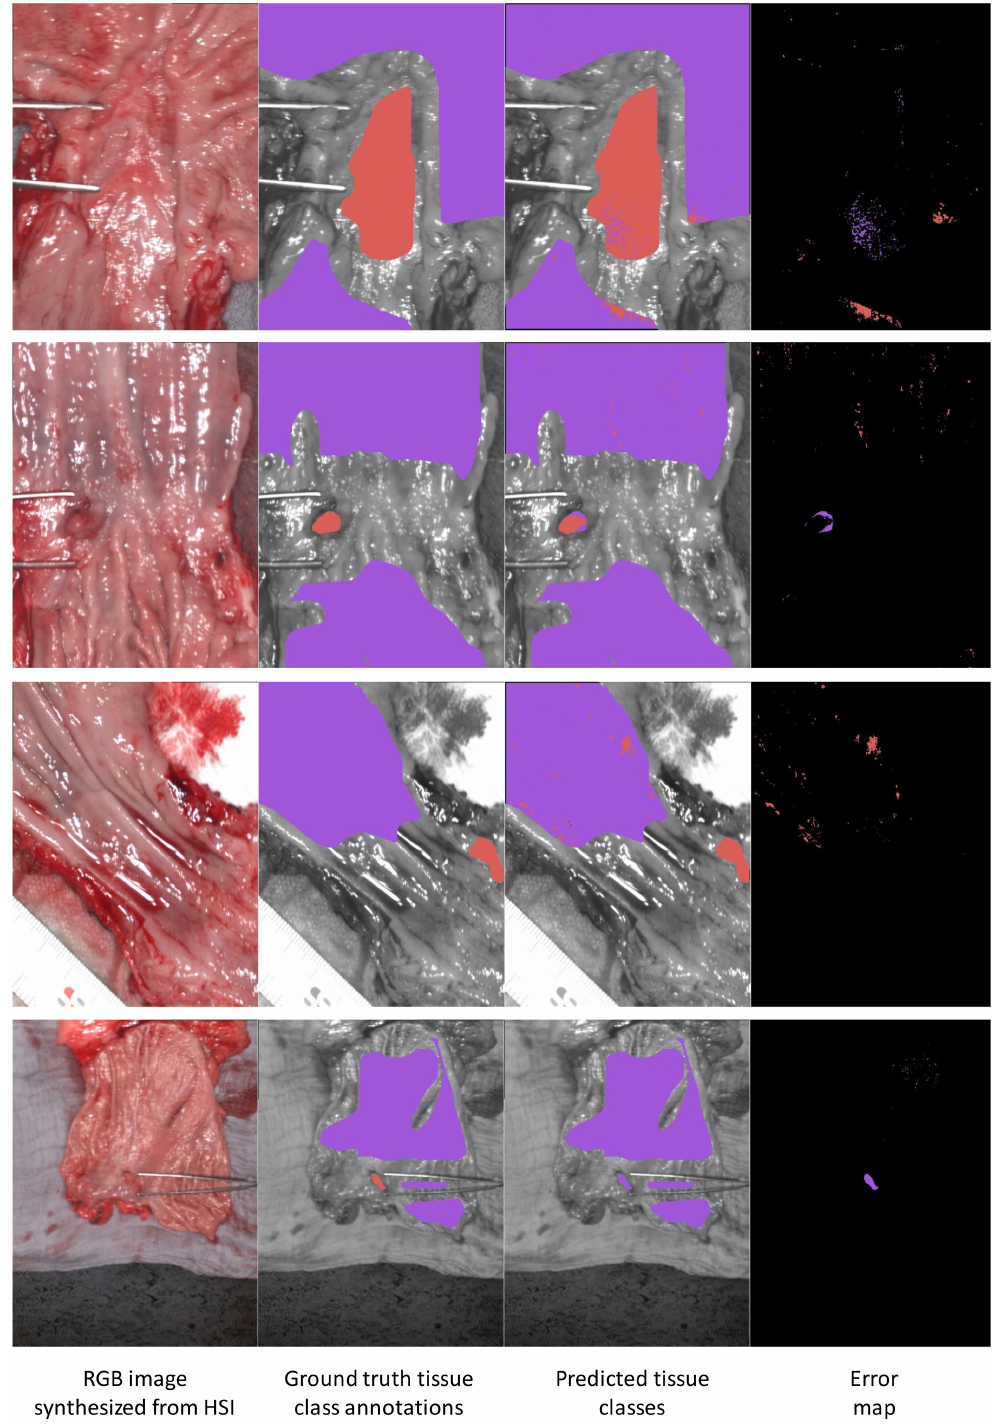
Figure 4. Visualization of results of the 3DCNN model on the esophagogastric dataset. Each row of images represents a patient (from top to bottom, patients 21, 19, 14 and 20). Each row of images shows four images. From the left, these are: (1) The RGB image synthesized from the hypercube. (2) The ground truth tissue class annotations provided by the surgeon. (3) The predicted tissue classes predicted by the 3DCNN. (4) The error map. Colored pixels in the error map indicates pixels where the 3DCNN prediction differed from ground truth. The displayed color is the color of the incorrect prediction from the 3DCNN. Pixels in red correspond to the tumor class, and pixels in purple correspond to the healthy tissue